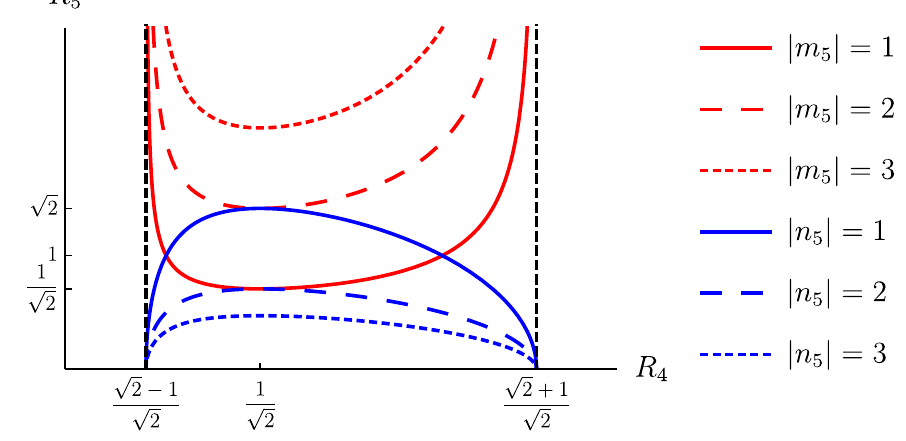
Figure 1 . Boundary curves of the regions of the plan ( R 4 ; R 5 ) where KK or winding modes along S 1 ( R 5 ) are tachyonic in the parent model, which realizes the N = 4 ! N = 0 spontaneous breaking. The remaining quantum numbers of these states are 2 m 4 = (cid:0) n 4 = (cid:15) and m 6 = n 6 = (cid:1) (cid:1) (cid:1) = m 9 = n 9 =